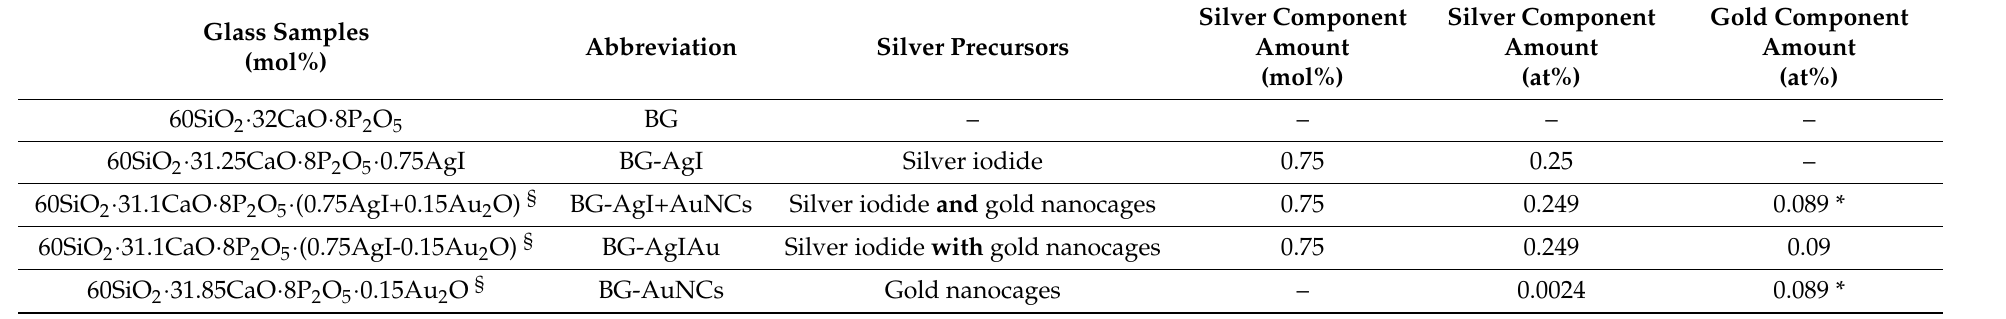
Table 1. Abbreviation and composition of